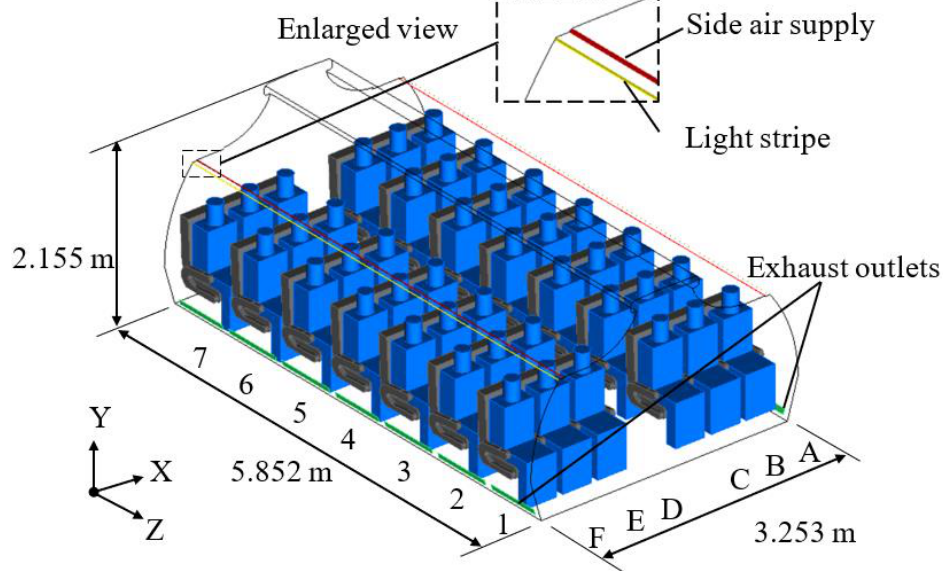
Figure 1. Geometric model of the aircraft cabin in the reference case (Case 1).